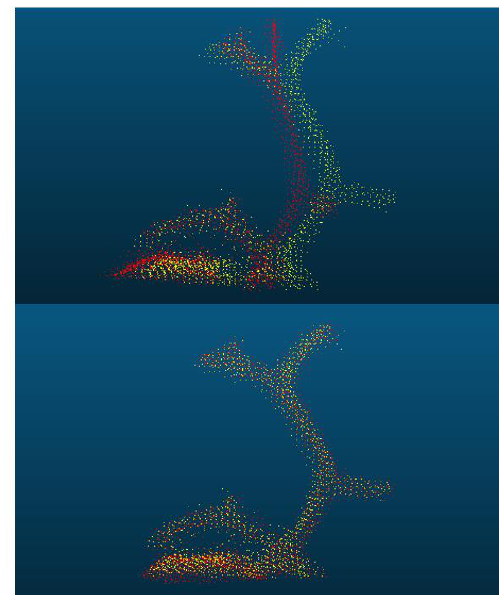
Figure 12. Aligned antler point cloud from two different sampling